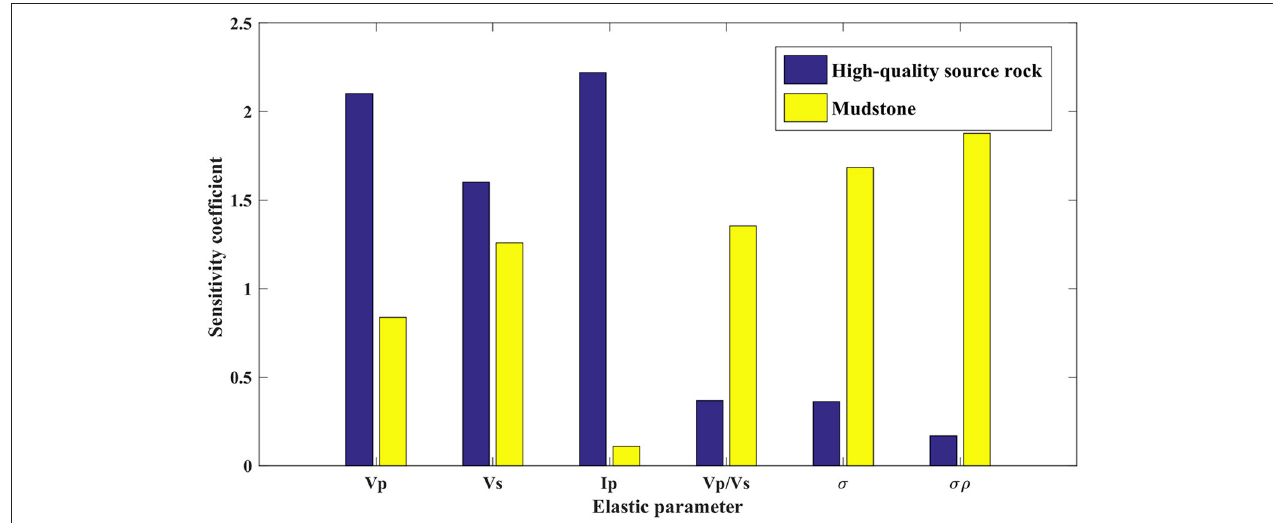
FIGURE 11 | Diagram of the P-wave impedance versus Poisson impedance of varying TOC content and mud content based on the rock physical model of the mud-rich source rock.